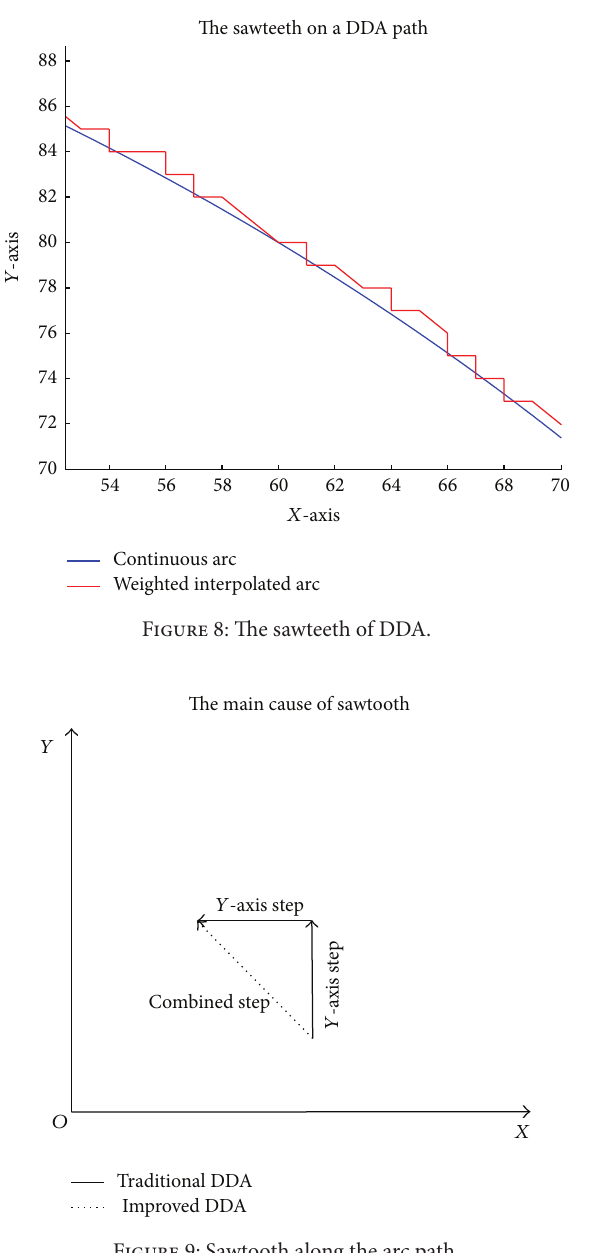
Figure 11: Detailed comparison between traditional and improved